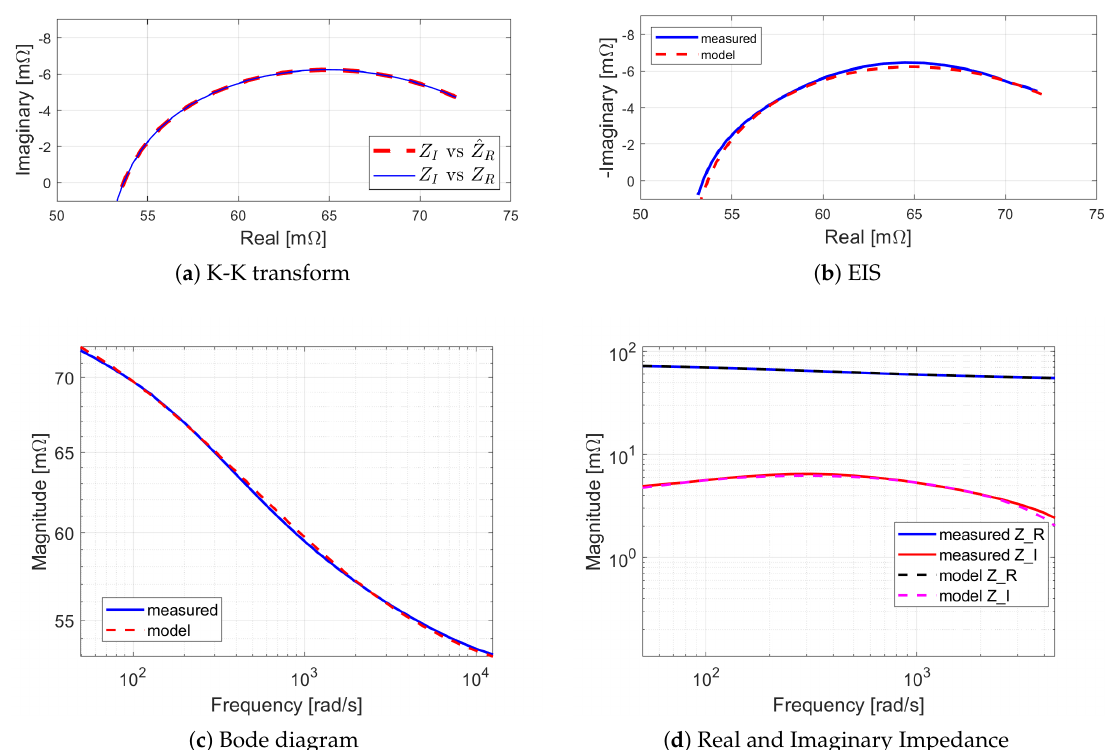
Figure 4. Measured impedance spectra versus expected values, ( a ) Electrochemical Impedance Spectroscopy (EIS) plot, versus Expected values using K-K transforms, ( b ) EIS plot, versus the ECM model, ( c ) Bode diagram, versus the Equivalent Circuit Model (ECM) model, ( d ) Real and Imaginary parts of impedance versus the ECM